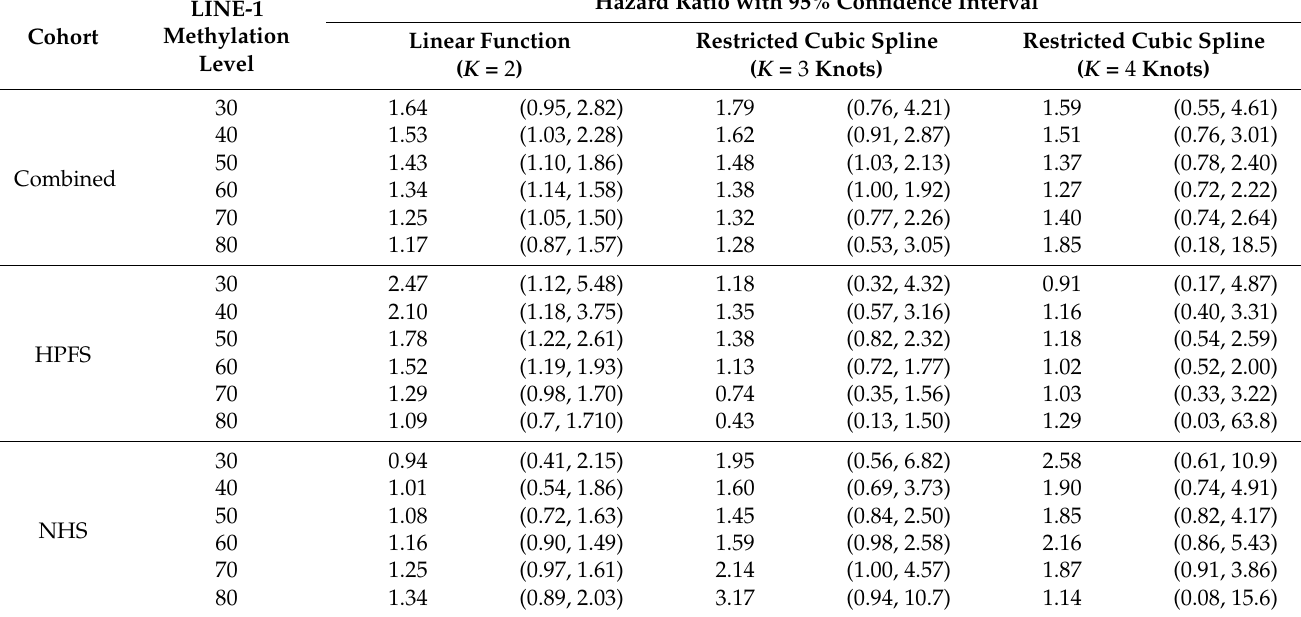
Table 2. Hazard ratio for categorical alcohol intake (>15 g/day vs. 0 g/day) modeled using three functional forms for the LINE-1 marker value in three cohort settings, based on the main